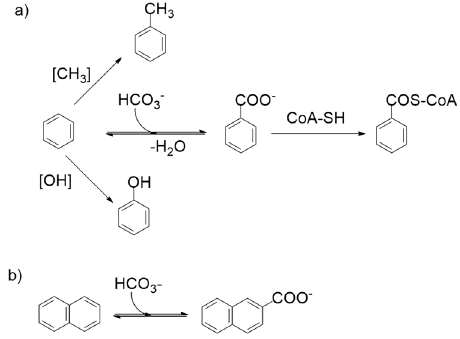
Figure 24. Putative anaerobic degradation pathways of benzene ( a ) and naphthalene ( b ).